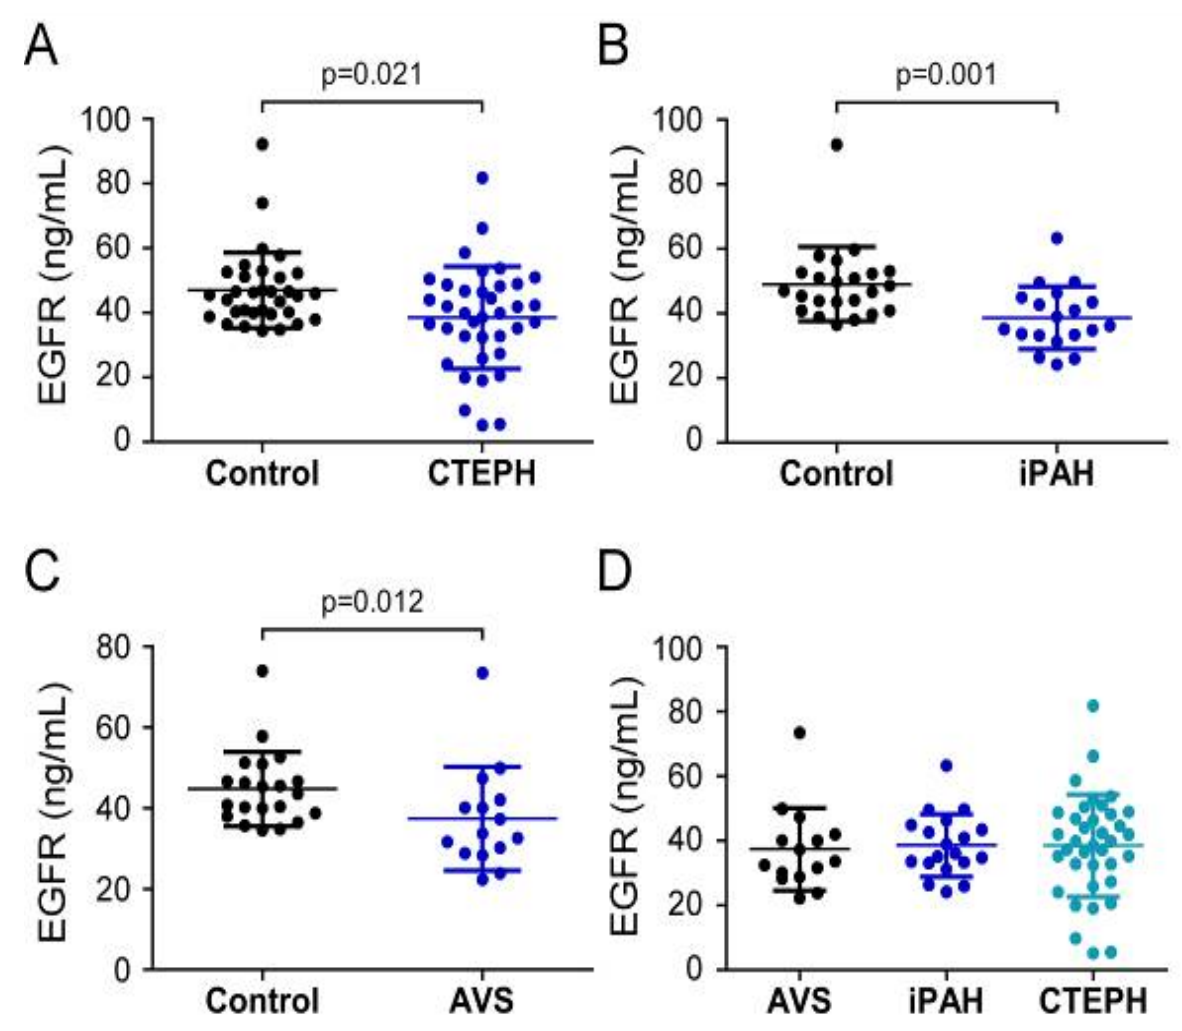
Figure 4. Serum concentrations of EGFR in ( A ) CTEPH, ( B ) iPAH, and ( C ) AVS patient groups and controls. ( D ) Comparison of EGFR levels between AVS, iPAH, and CTEPH patients. Each dot represents one donor. Arithmetic means and standard deviations are indicated by horizontal lines. Patient groups were compared to controls by Mann–Whitney U test. One-way ANOVA with Bonferroni–Holm post hoc test was used to compare 3